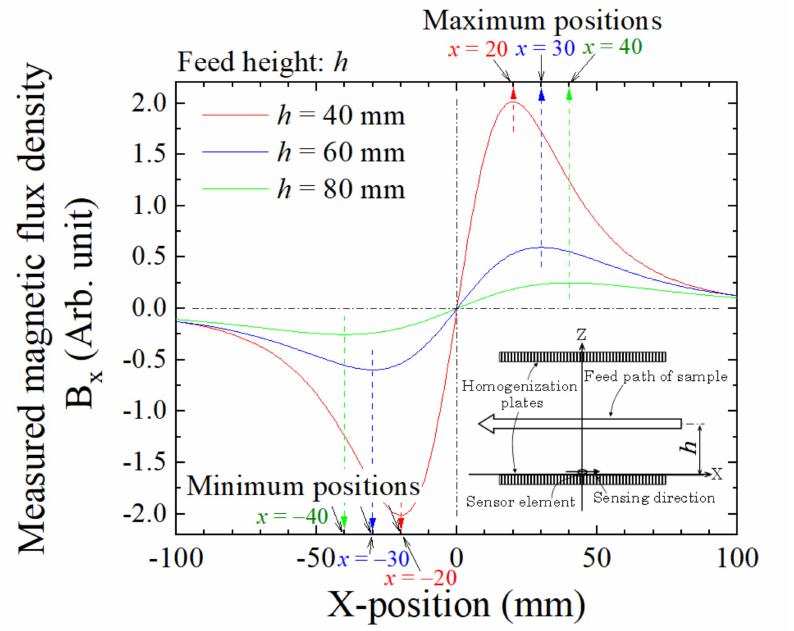
Figure 3. Relationship between the feeding height of a magnetic dipole and the position of an extreme point of measured magnetic flux density